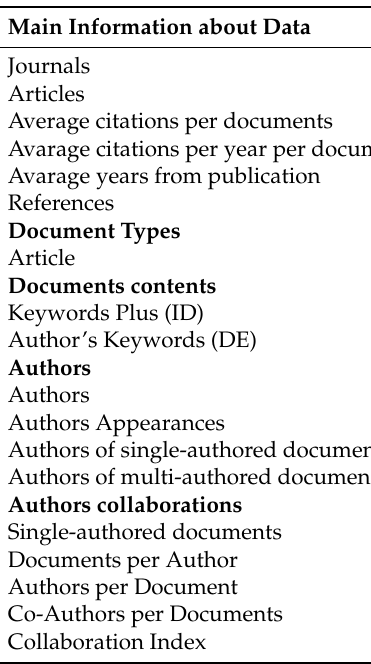
Table 1. Summary of information on stress and burnout in teachers during the COVID-19